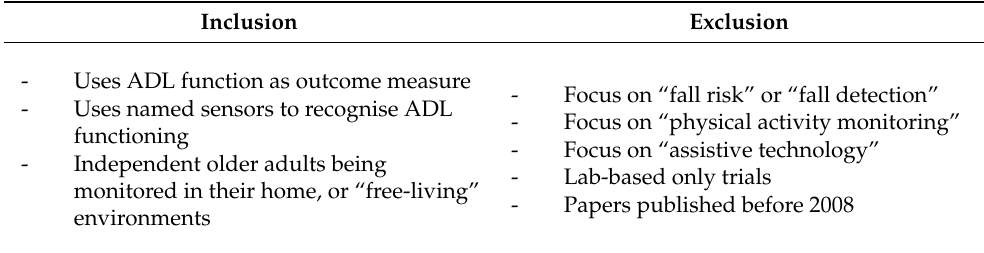
Table 1. Inclusion and exclusion criteria for the paper selection